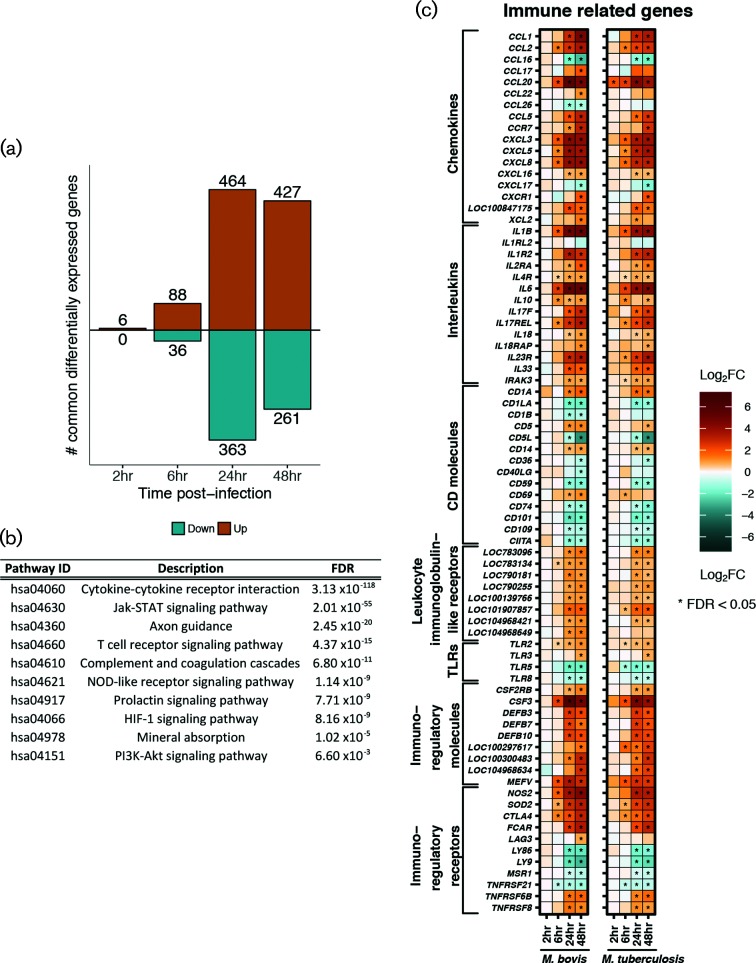
(a) The number (y-axis) and direction of change (up=orange, down=cyan) of genes that are commonly differentially expressed (‘core response’) (|log2FC|>1, FDR<0.05, with non-significant delta comparison values) in bovine alveolar macrophages infected with M. bovis AF2122/97 and infected with M. tuberculosis H37Rv at 2, 6, 24 and 48 h p.i. (b) Pathways enriched for 688 genes that are commonly differentially expressed (‘core response’) in bovine alveolar macrophages infected with M. bovis AF2122/97 and M. tuberculosis H37Rv over the first 24 h of infection (FDR<0.05). (c) Genes that are commonly differentially expressed (‘core response’) [|log2FC|>1, FDR<0.05 (‘*’)] and associated with the innate immune response in bovine alveolar macrophages infected with M. bovis AF2122/97 (left column) or M. tuberculosis H37Rv (right column) over 48 h p.i.